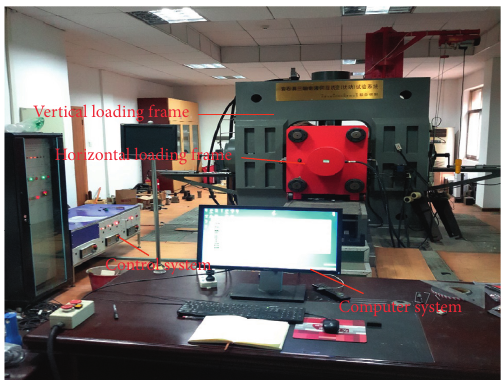
Figure 1: TRW-3000 rock mechanics test